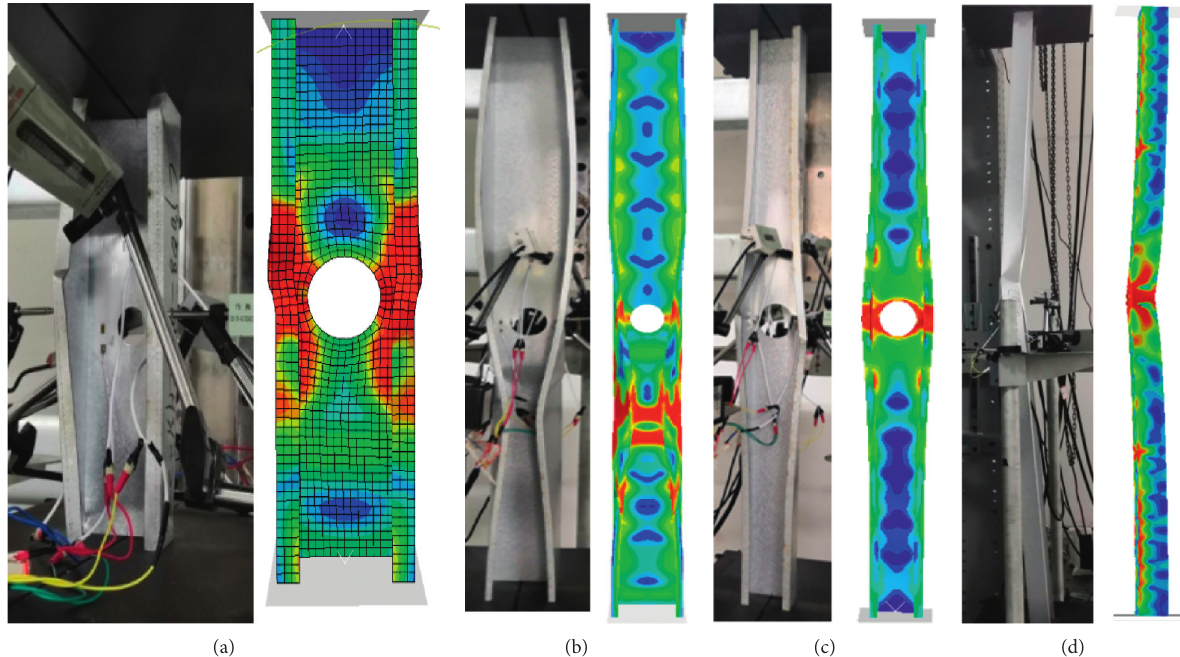
Figure 16: Comparison of failure modes of specimens between test and finite element analysis. (a) C90-05-1H7-2. (b) C90-10-1H5-2. (c) C90-10-1H7-2. (d)